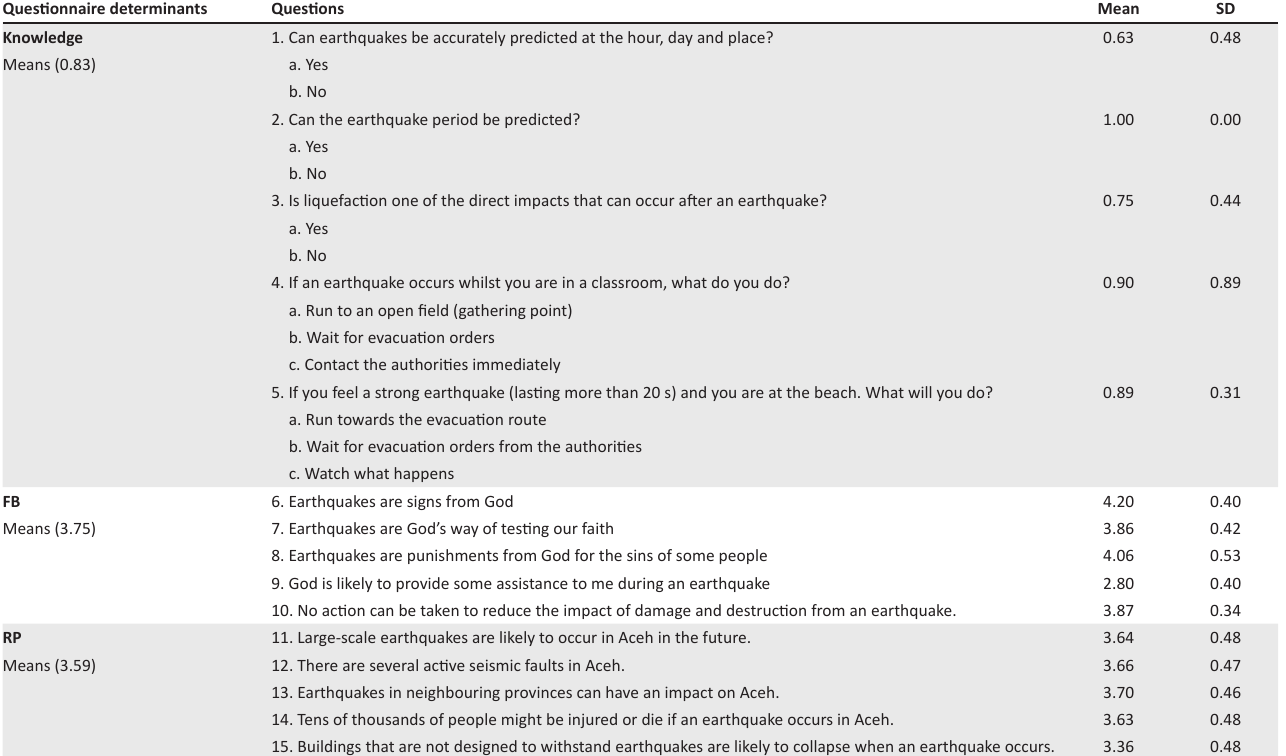
TABLE 1: Questionnaire for knowledge, fatalism beliefs and risk perception. Questionnaire